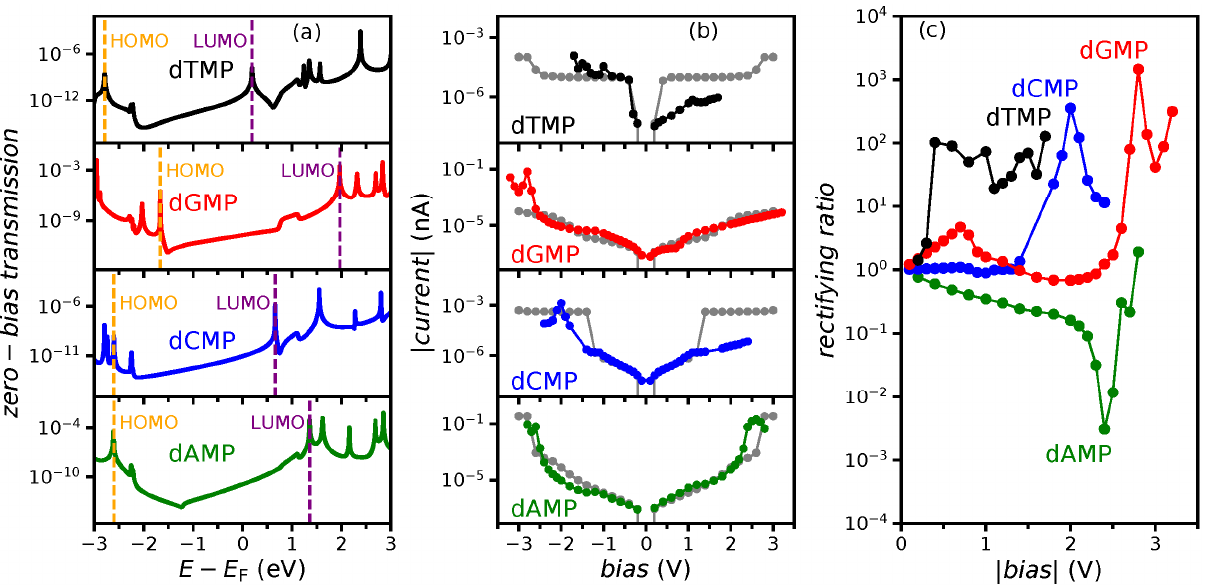
Figure 5. ( a ) Zero-bias transmission spectrum T ( E ,0), ( b ) absolute tunneling current | I |, and ( c ) rectifying ratio RR of the four nucleotides. In ( a ), orange and purple dashed lines mark the zero-bias HOMO and LUMO energies, while in ( b ), the gray curves are absolute currents obtained from the zero-bias approximation.